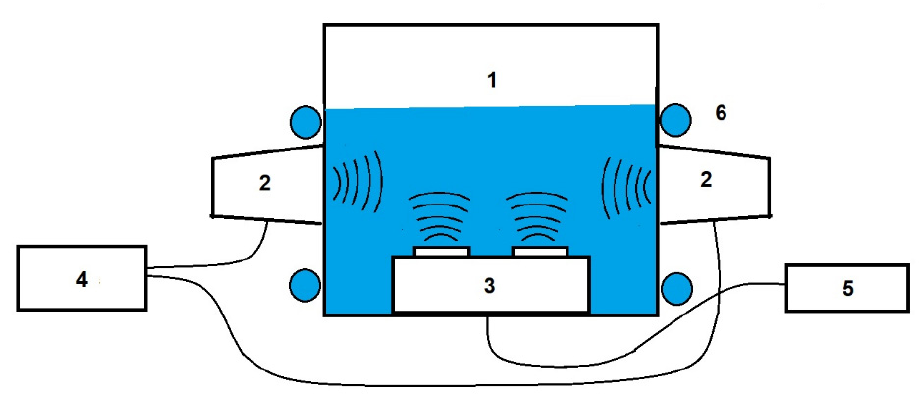
Figure 1. A scheme of a dual-frequency sonoreactor. 1—stainless steel bath, 2—piezoceramic transducer (120 kHz), 3—piezoceramic transducers and generator unit (1700 kHz), 4—ultrasonic generator (120 kHz), 5—power unit (48 V), 6—cooling tubes.